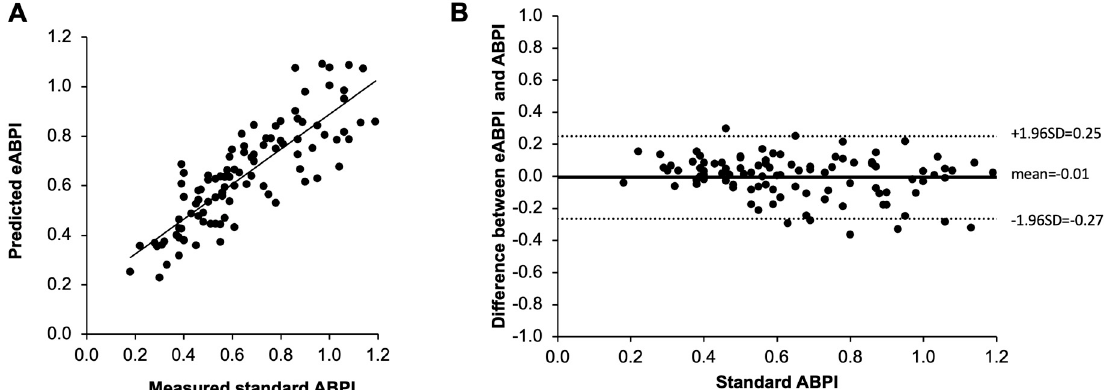
Figure 2. Validation of eABPI using AccI from handheld Doppler and best-fit curve estimate from Figure 1C compared to standard ABPI measured with handheld Doppler probe and cuff occlusion. ( A ) Significant correlation between eABPI and ABPI ( r = 0.85, p < 0.001). ( B ) Bland Altman plot demonstrating an average deviation of − 0.01 when comparing eABPI with ABPI with a standard deviation of differences of 0.13 ( n =